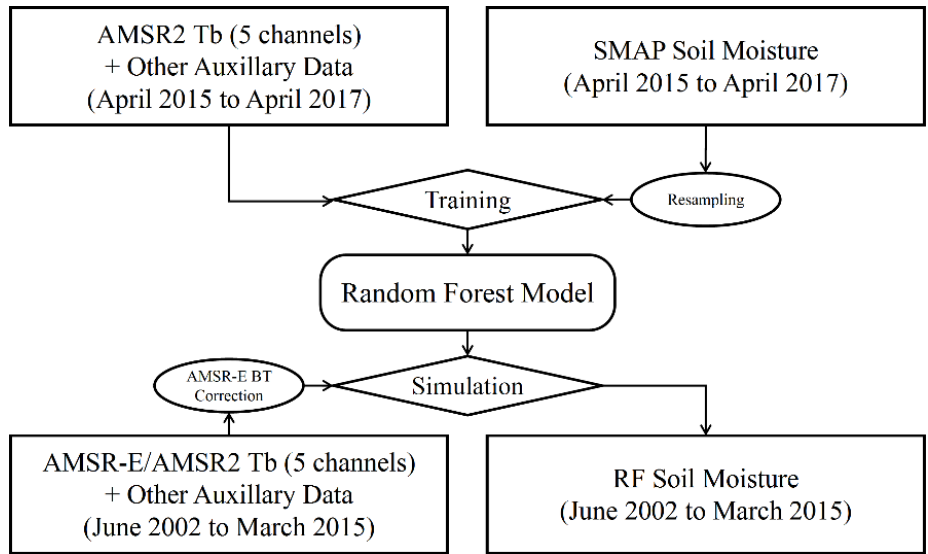
Figure 2. Flow chart of the random forest soil moisture (RFSM) product process.